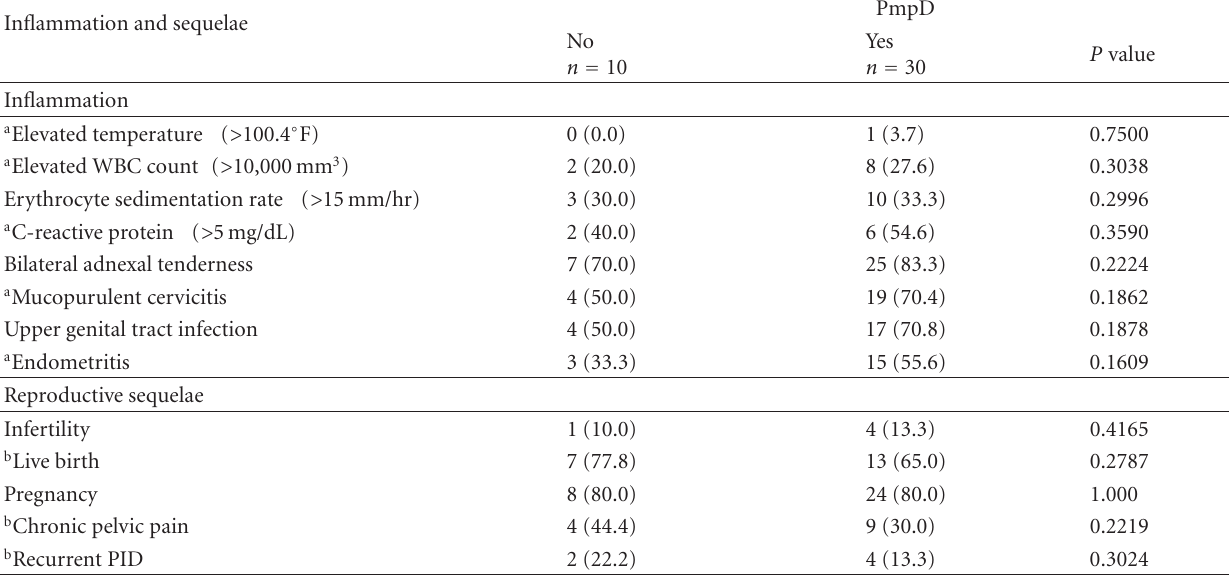
Table 3: Frequency of baseline inflammatory markers and reproductive sequelae by PmpD antibody expression. Inflammation and